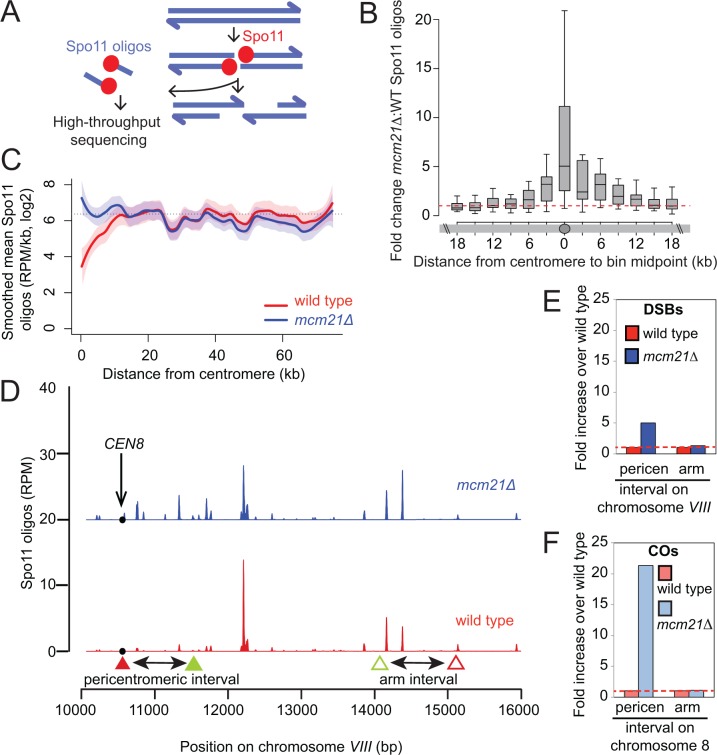
The kinetochore protects the centromere-proximal domain from DSBs.(A) Sequencing of Spo11-oligos allows DSBs to be mapped genome wide. (B) Fold change in average Spo11-oligo density (RPM per kb) in 3 kb segments in mcm21△ cells compared to wild type (from Zhu and Keeney (2015)), over a 36 kb region surrounding all 16 centromeres. Boxes show median and interquartile range, whiskers enclose data points within 1.5 times the interquartile range; outliers are not shown. Red dashed line, fold change of one. (C) Mean Spo11 signal as a function of distance from the centromere. Spo11 oligo density within 500 bp bins starting from the centromere and moving up to 75 kb away, averaged across the 32 chromosome arms was determined. The horizontal dotted line indicates genome average. The red (wild type) and blue (mcm21△) lines indicate loess smoothing, and the shading indicates the 95% confidence interval. (D) DSBs in the region examined in the CO assay. Spo11 oligo counts smoothed with a 201-bp Hann window are shown. The black circle indicates the centromere, filled triangles indicate the midpoints of coordinates where RFP (red) and GFP (green) cassettes were targeted to for CEN8 analysis in the live cell recombination assay; open triangles indicate the locations where the cassettes were targeted to for ARM8 analysis. (E and F) Fold change in the number of DSBs (E) or COs (F) in mcm21△ vs. wild type within the same pericentromeric or arm intervals on chromosome 8 that were analyzed in the live cell recombination assay (Figure 1B and C). CO, crossover; DSBs, double strand breaks; RPM, reads per million mapped.